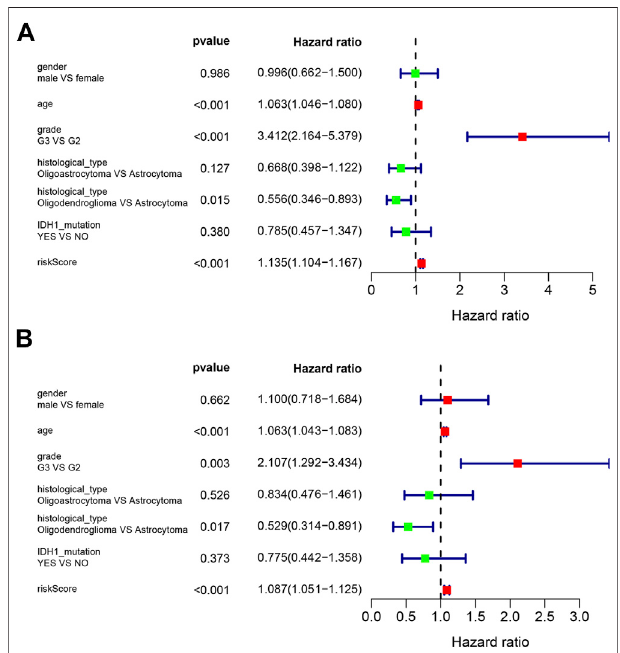
FIGURE 5 | Forest plots of prognostic risk factors (A) univariate Cox regression forest plot. (B) multivariate Cox regression forest plot of independent risk